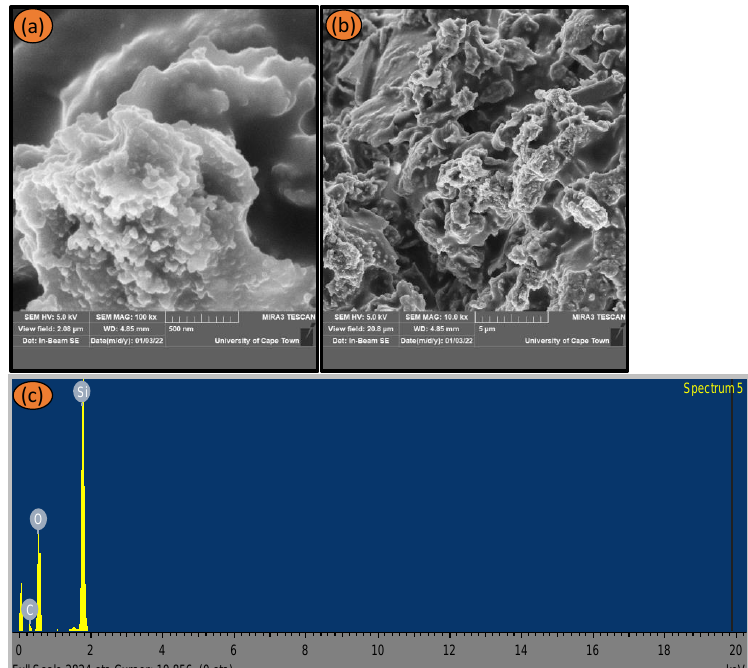
Figure 4. SEM micrograph presentation of ( a ) leached silica (low magnification), ( b ) leached silica (high magnification) and ( c ) SEM-EDX of as-synthesized L-cys-TPAH silica treated with L-cysteine Hydrochloride.